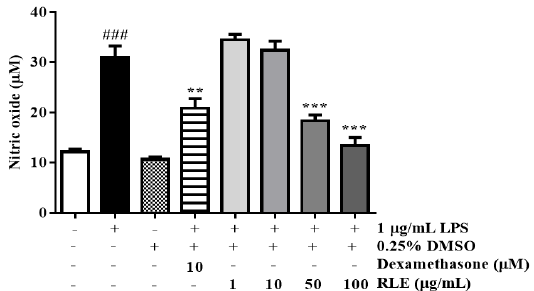
Figure 4. The effects of R. davurica Pall. leaf extract on nitric oxide production in LPS − induced RAW 264.7 cells. Data are presented as the mean ± SD. # and * indicate significant differences between the non ‐ treated cells and LPS − induced groups, respectively. ### p < 0.001 vs. the non − treated group. ** and *** p < 0.01 and 0.001 vs. the LPS − induced control, respectively.